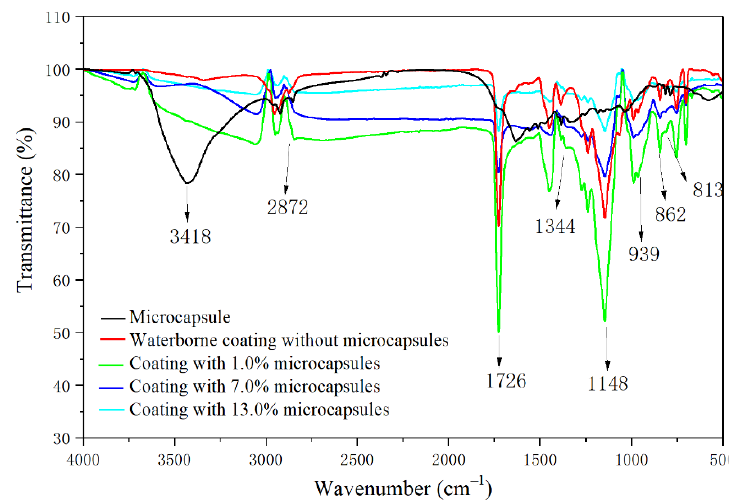
Figure 5. FTIR image of the microcapsules and coatings.